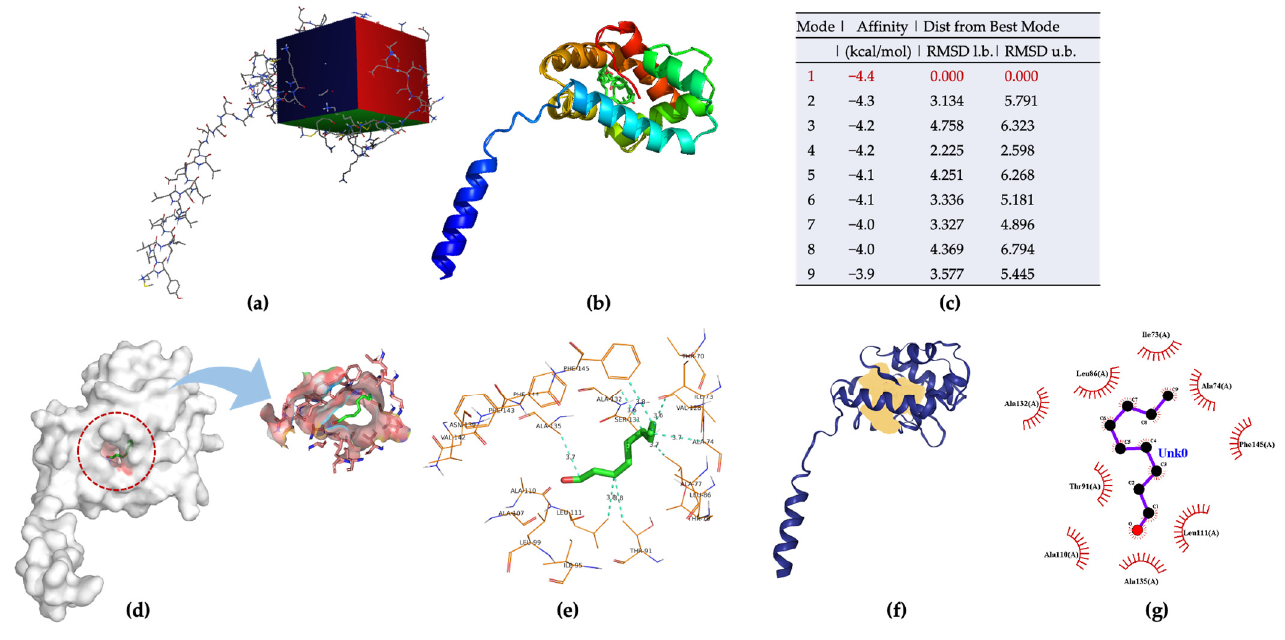
Figure 7. ( a ) Grid box for Aaegobp39-nonanal docking model; ( b ) nine docking modes predicted using AutoDock Vina; ( c ) ranking results of docking model; ( d ) 3D visualization of the best docking model; ( e ) binding residues identification; ( f ) best position of predicted binding pocket; ( g ) 2D ligand–protein interaction diagrams of Aaegobp39 with nonanal.